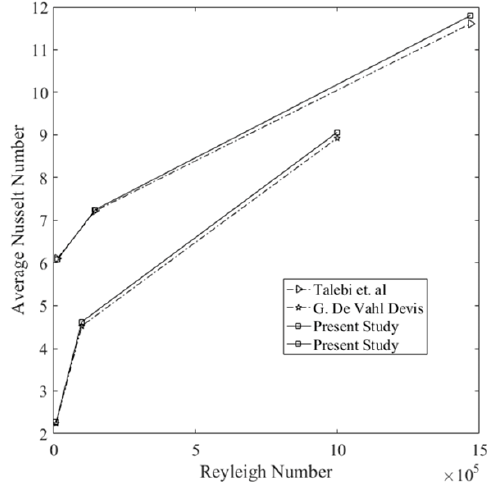
Figure 4. Scheme validation of the present